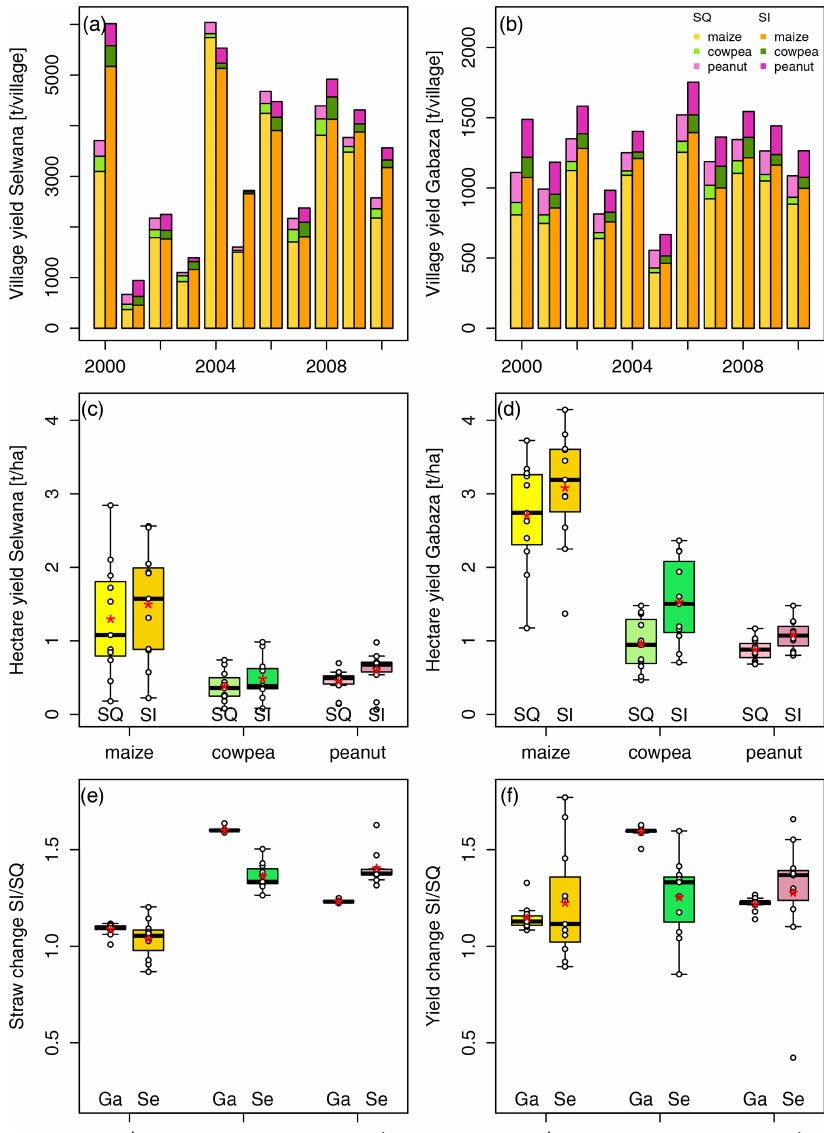
Figure 4. Time series of village-scale crop grain yields for Gabaza (a) and Selwana (b) under status quo (SQ) management and sustainable intensification (SI), and hectare-specific grain yields at Gabaza (c) and Selwana (d) . Panels (e) and (f) summarize the change in grain yield and straw quantity between the SI and SQ scenarios at Gabaza (Ga) and Selwana (Se) for maize, cowpea, and peanut, respectively. The white dots in panels (c) to (f) depict the values of individual years, and red asterisks represent the mean